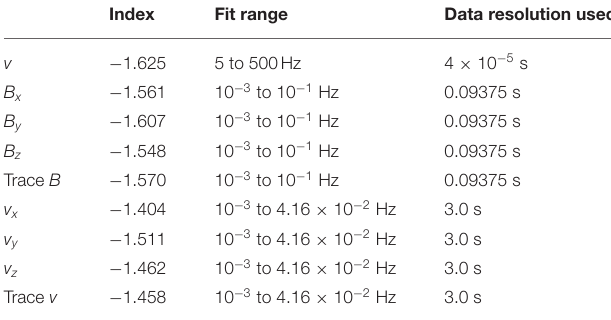
TABLE 3 | Spectral fits in the inertial